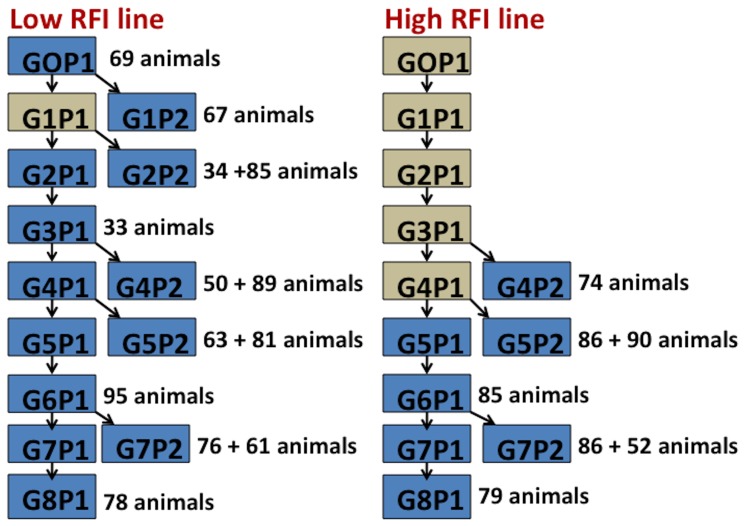
Population sampled.The animals in blue boxes were phenotyped and genotyped and included in the analyses. G: Generation; P: Parity. Please refer to references [2], [10] for the population structure, which defines generation and parity.